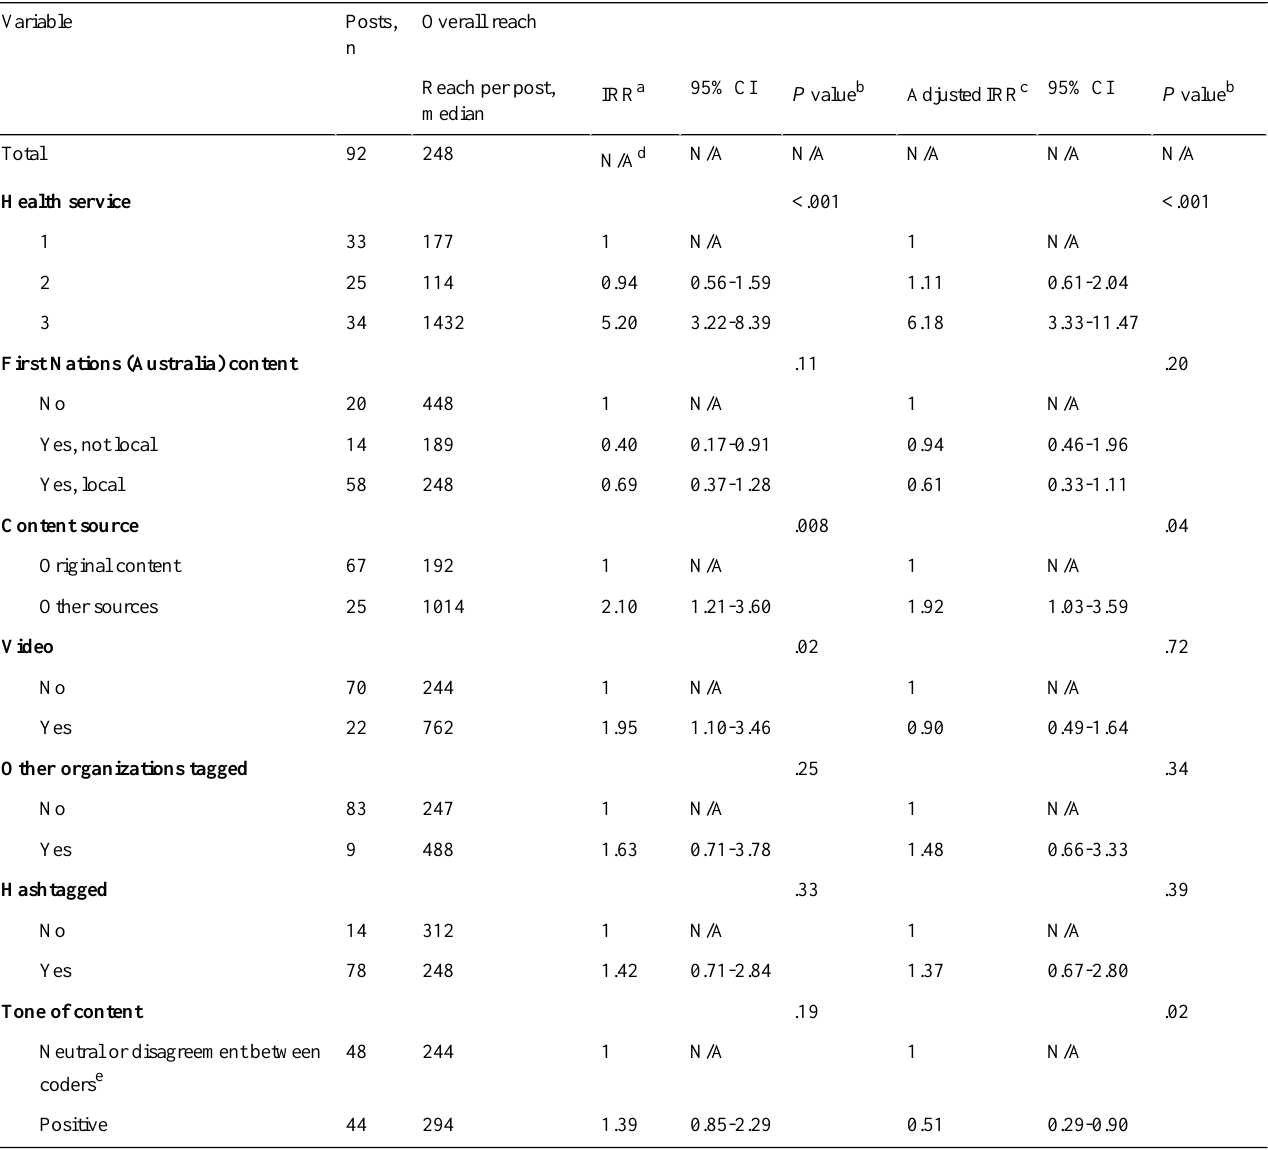
Table 1. Overall reach of each type of post (both of the original post and when shared).